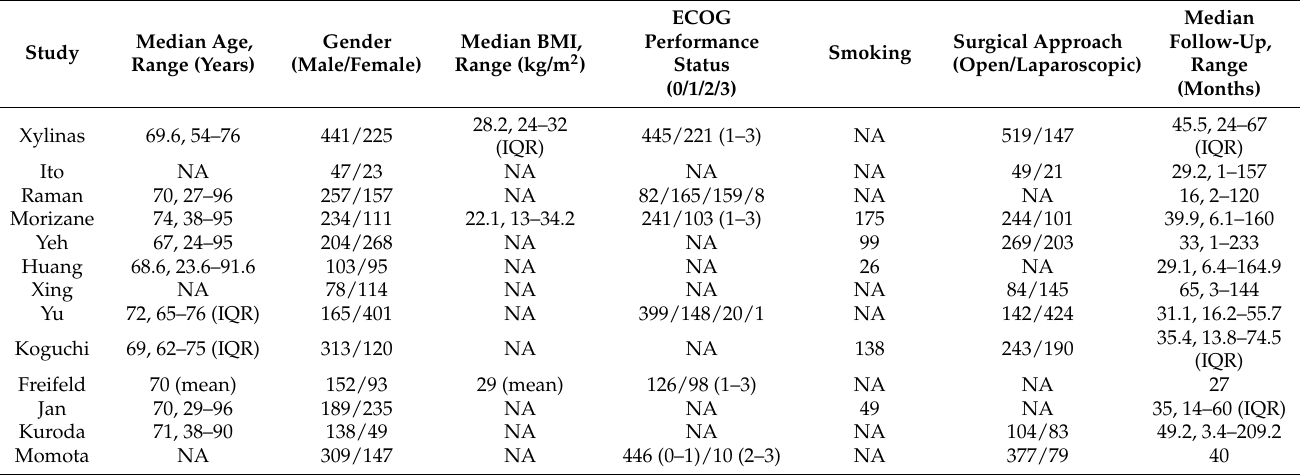
Table 2. Patient characteristics of the eligible